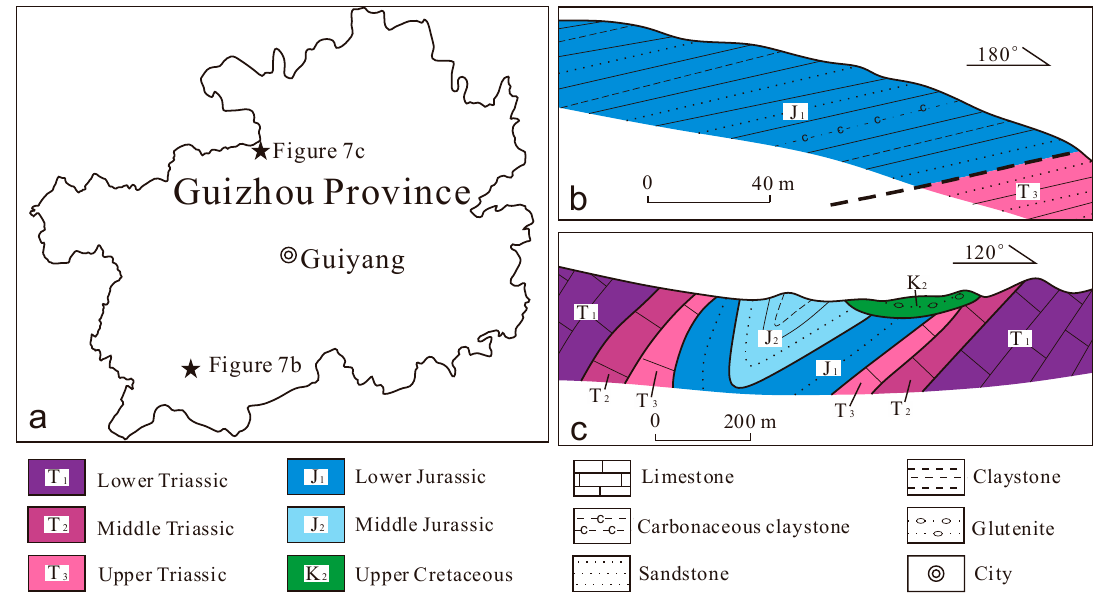
Figure 7. Two cross-sections in Guizhou Province showing the contact relations from the Lower Triassic to the Upper Cretaceous systems. ( a ) Geographical map of Guizhou showing the locations of the geologic cross sections; ( b ) Geologic cross section near the Zimudang Au deposit showing Jurassic strata is unconformably parallel to and folded with Late Triassic strata; ( c ) Geologic cross section north of Guizhous showing Late Cretaceous strata is angularly unconformable to Middle Jurassic rocks.